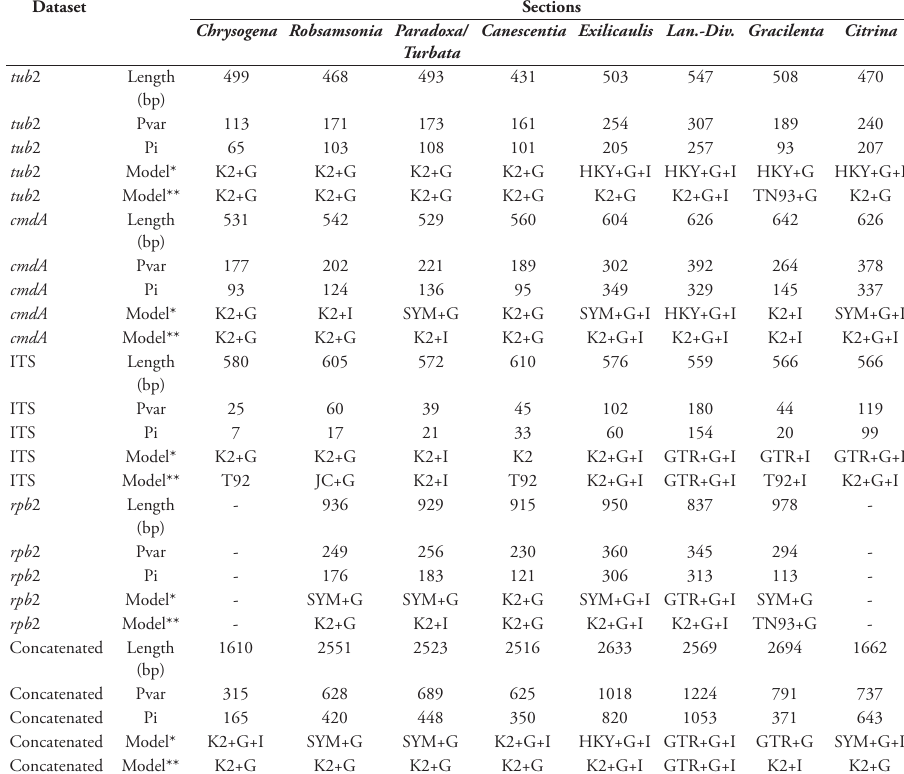
Table 2. Overview and details used for phylogenetic analyses in sections of Penicillium analysed in this study. Dataset Sections Chrysogena Robsamsonia